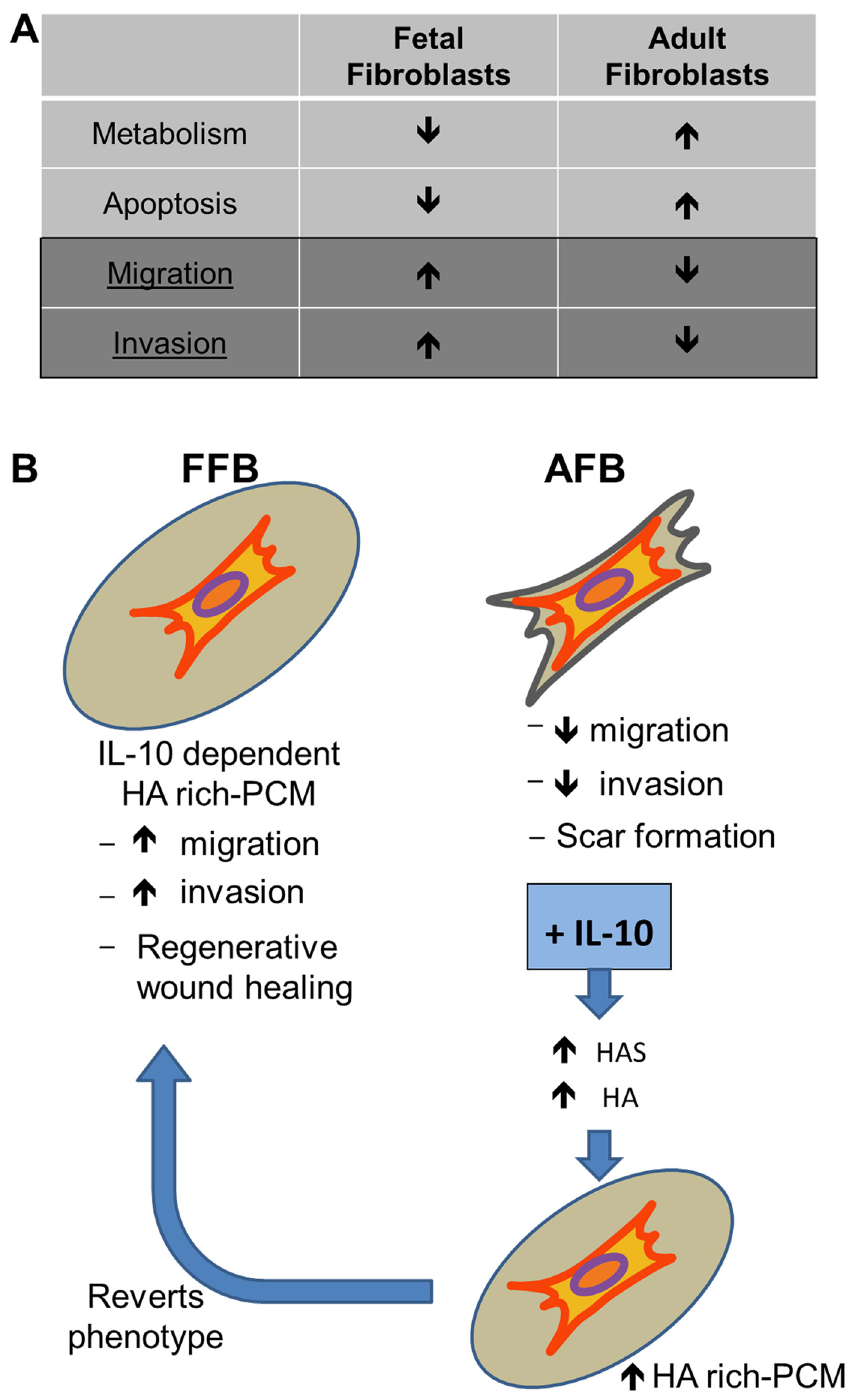
Fig 5. FFB have a distinct functional profile from AFB. A) FFB demonstrates decreased rates of metabolism and apoptosis and increased rates of cellular migration and invasion compared to AFB. IL-10 treatment can recapitulate the fetal functional phenotype of enhanced migration and invasion in AFB. B) Mechanistically, our previous data has shown that fetal fibroblasts synthesize more HA and HA-rich pericellular matrices (PCM) compared to AFB. IL-10 in the fetus has a novel role in the regulation of the HA- rich ECM synthesis. This is the first report that demonstrates that IL-10 mediated HA synthesis regulates the migration and invasion of the FFB, we posit this regulation, in part, facilitates the fetal regenerative